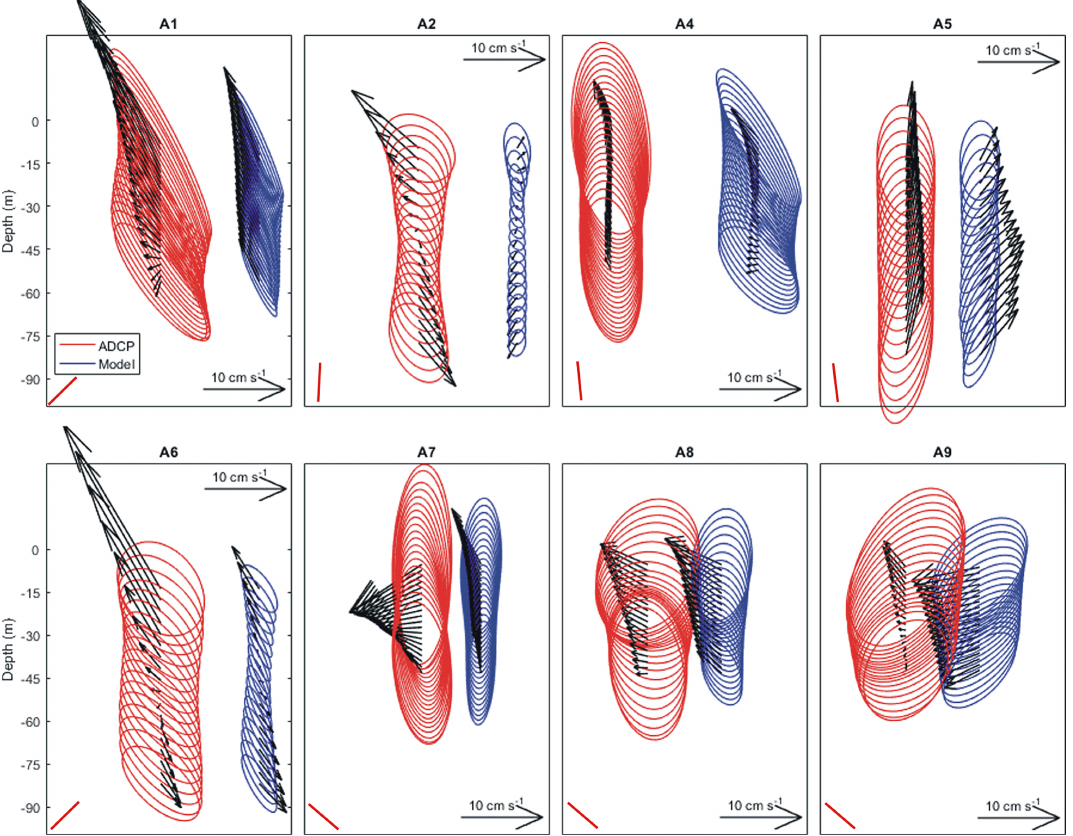
Figure 7. Mean residual currents and ellipses of standard deviations measured (red) and modelled (blue) at A1 to A9 stations between 1 February and 1 April 2015. Orientation of channel bathymetries in which stations have been moored is indicated by the red line in the left lower